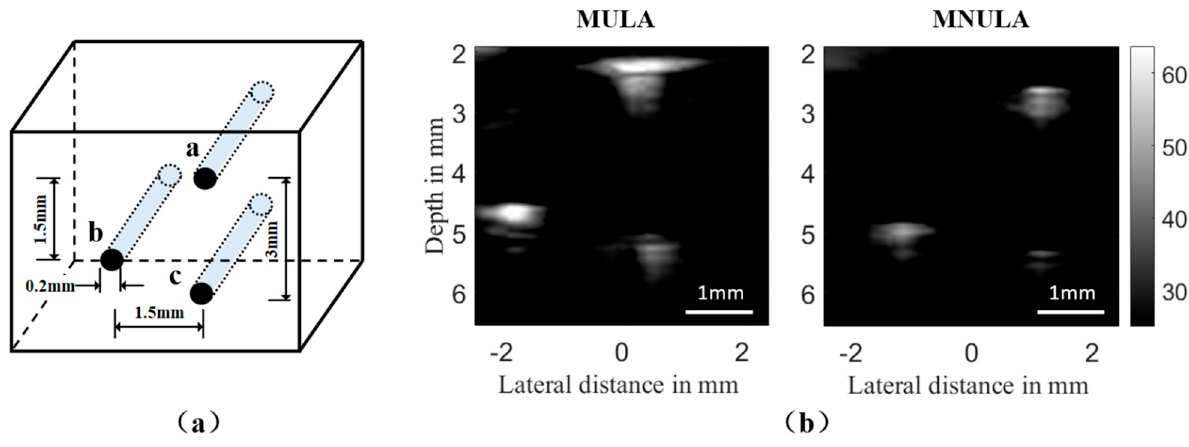
Figure 15. The laboratory-made phantom and comparisons between the experimental results of the MULA and the MNULA. ( a ) Enlarged schematic diagram for the phantom; ( b ) the enlarged imaging results of the phantom.